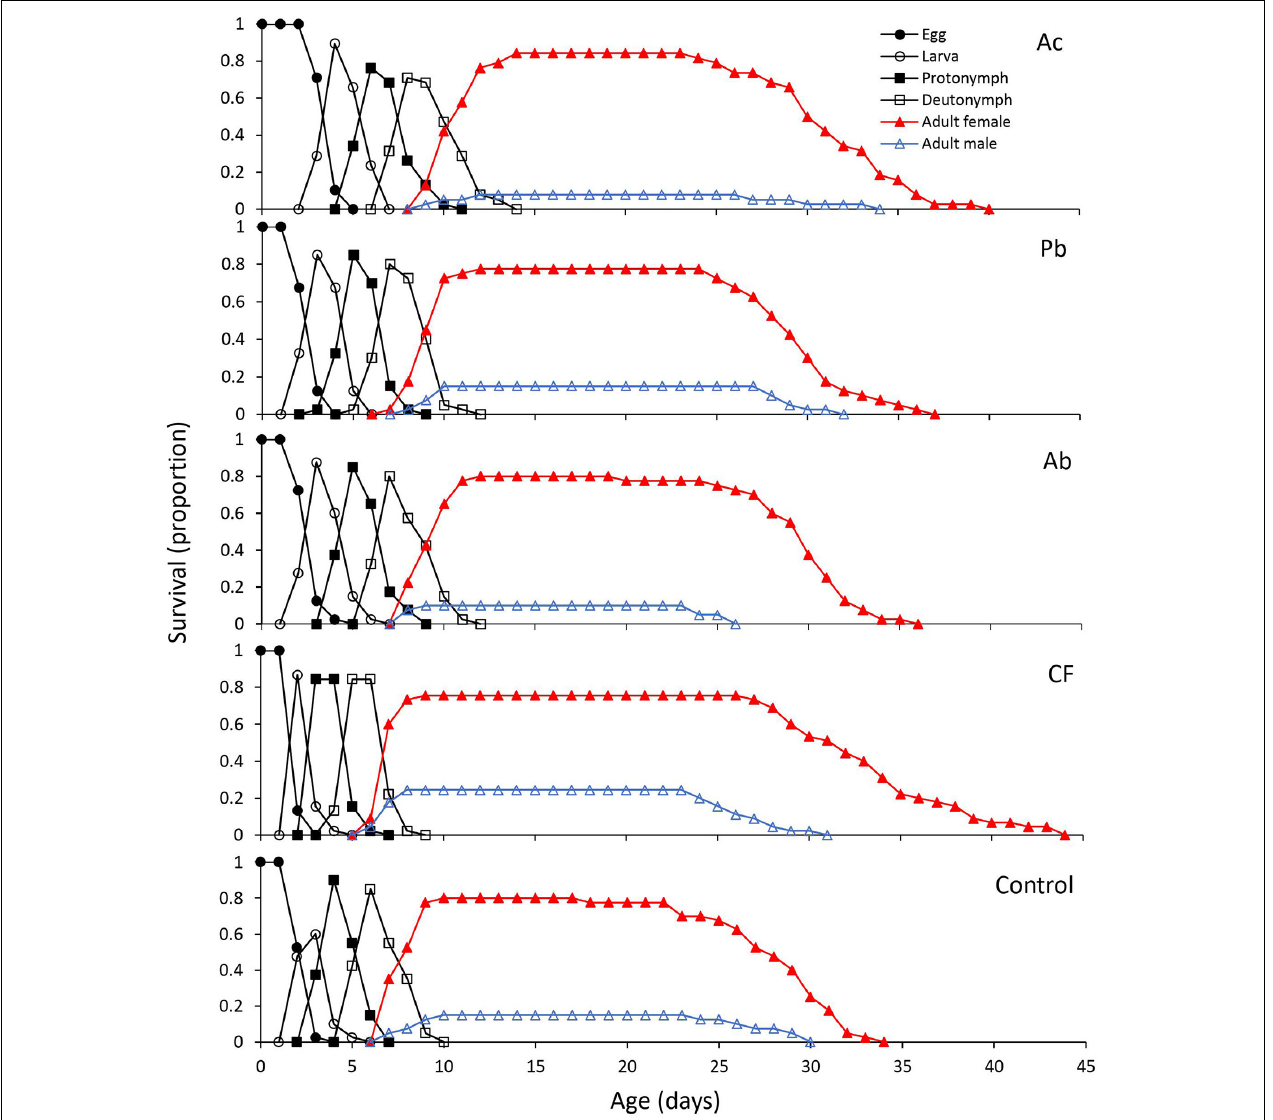
FIGURE 1 | Age-stage specific survival curve ( s xj ) of T. urticae reared on leaves from strawberry plants subjected to one of five treatments, Ac ( Azotobacter chroococcum ), Ab ( Azospirillum brasilense ), Pb ( Pseudomonas brassicacearum ), CF (chemical fertilizer), and control (untreated).